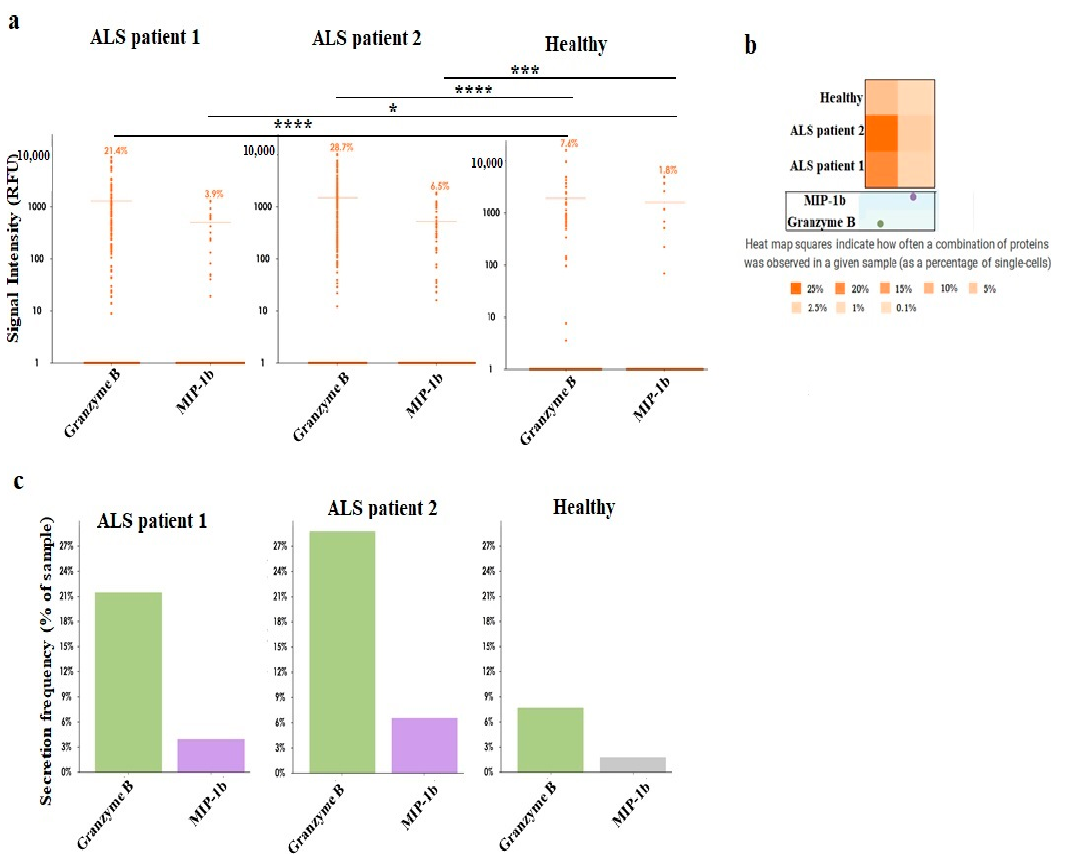
Figure 5. Determining the levels of Granzyme B and MIP-1b in CD8+ T cells of ALS patients and healthy individuals. CD8+ T cells from ALS patients and healthy individuals were treated with anti- CD3/28 antibody and secretion frequency of Granzyme B, and MIP-1b were measured at single cell level. ALS1 sample has 462 single cells; ALS2 sample has 536 single cells; and healthy control sample has 510 single cells. 21.4% of ALS1 ′ s single cells and 28.7% of ALS2 ′ s single cells secreted Granzyme B in comparison to only 7.6% of healthy control’s single cells secreting Granzyme B. In addition, 3.9% of ALS1 ′ s single cells and 6.5% of ALS2 ′ s single cells secreted MIP-1b in comparison to only 1.8% of healthy control’s single cells secreting MIP-1b. Granzyme B’s signal intensities from all single cells among 3 donors are significantly different. MIP-1b’s signal intensities from all single cells between ALS patients are not significantly different but MIP-1b’s signal intensities are significantly different between ALS patients and healthy control ( a ). Heatmap graphs indicates how often a combination of proteins was observed in a given sample. Heatmaps compare the percentage of single cells secreting various monofunctional and polyfunctional groups across multiple samples. ALS samples possess higher percentage of single cells secreting Granzyme B or MIP-1b; and higher percentage of single cells co-secreting Granzyme B with MIP-1b ( b ). CD8+ T cells from ALS patients and healthy individuals were treated with anti-CD3/28 antibody and secretion frequency of Granzyme B, and MIP-1b were measured at single cell level ( c ). One of five representative experiments is shown in ( c ). **** ( p -value <0.0001), *** ( p -value 0.0001–0.001), * ( p -value 0.01–0.05).